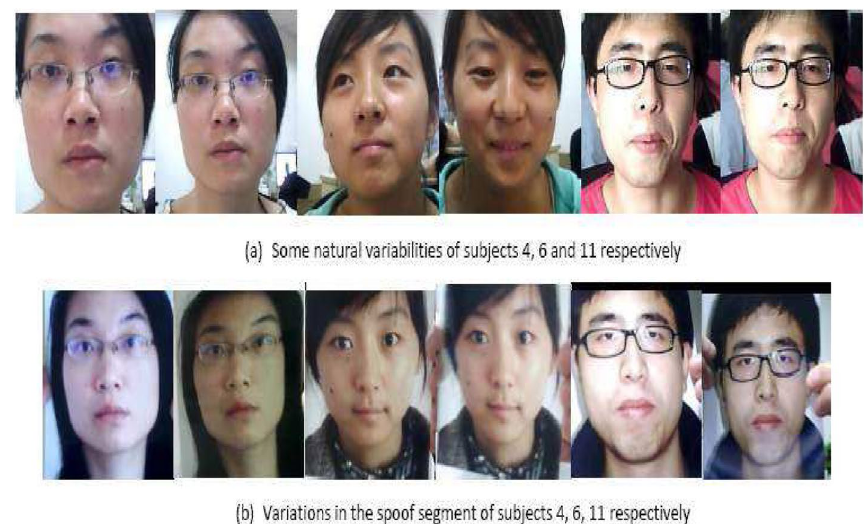
Fig. 12 Anomalous cases in CASIA which have a tendency to induce mis-classifications (Subjects 4, 6 and 11); ( a ) Some natural variations; ( b ) Spoof variations; Ordering is Subject 4, 6 and then